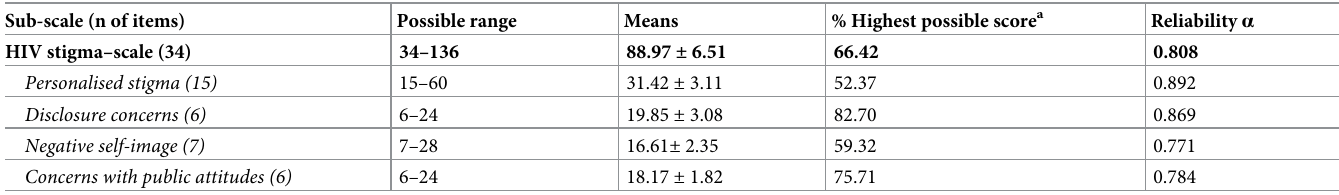
Table 4. Reliability coefficients for overall HIV stigma scale and sub-scales.